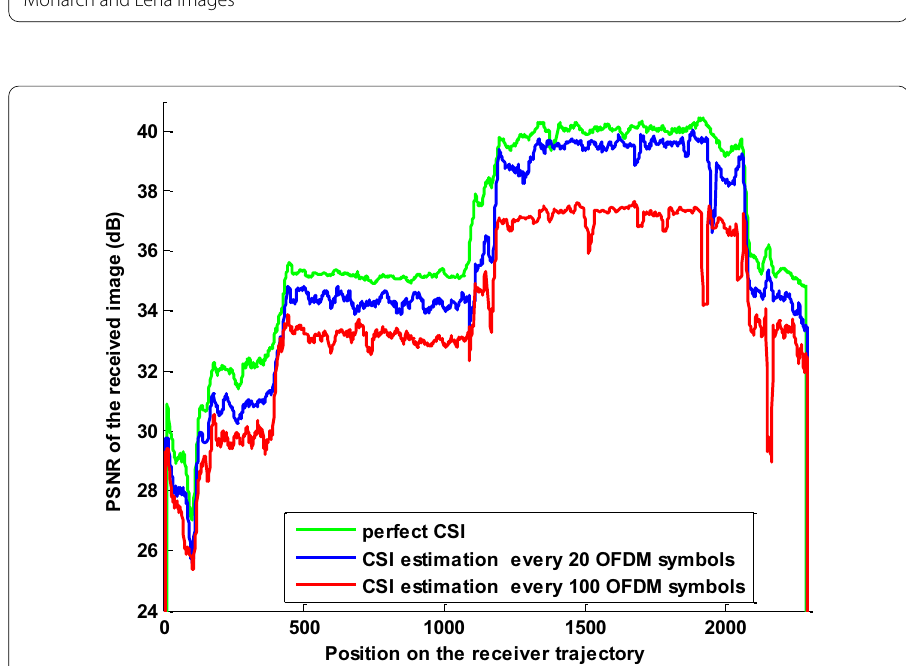
Fig. 17 PSNR of the Monarch image for different CSI levels. the PSNR of Monarch image obtained by using the proposed scheme for different CSI